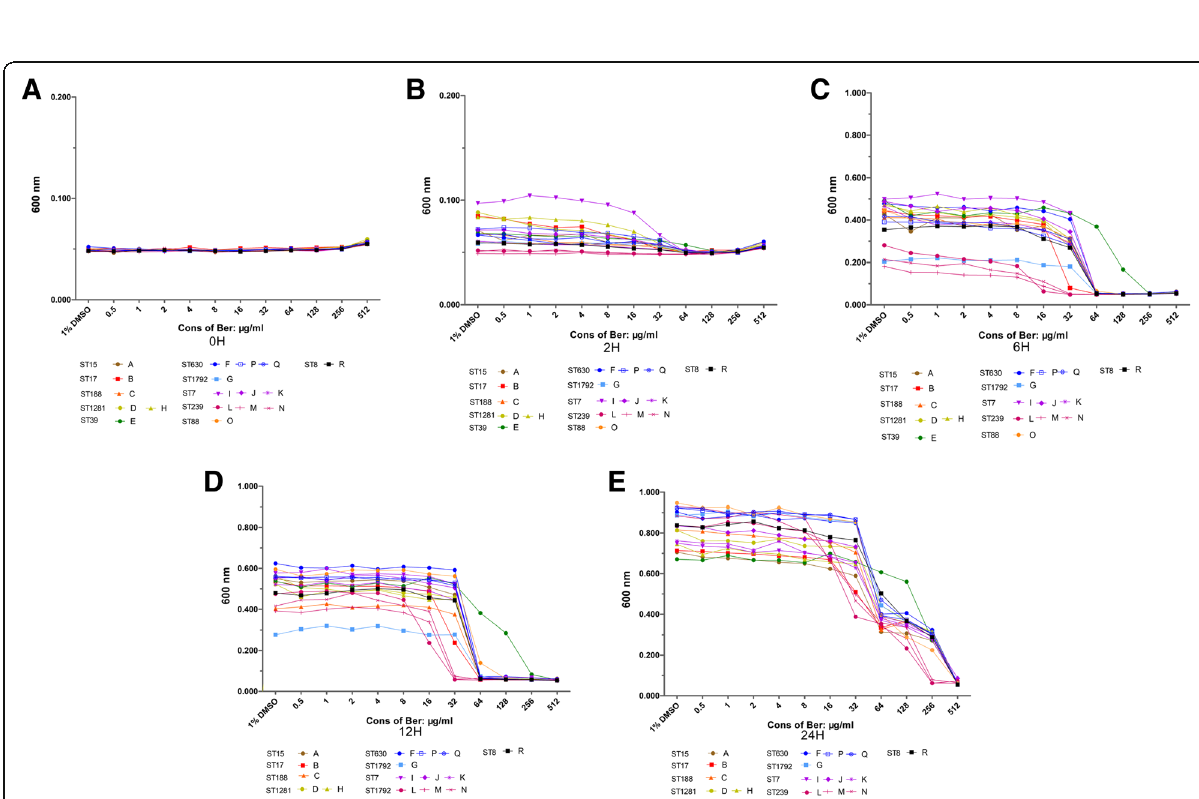
Fig. 2 Growth kinetics of clinical S.aureus in the presence of different berberine concentrations after incubation of 0 h ( a ); 2 h ( b ); 6 h ( c ); 12 h ( d ) and 24 h ( e